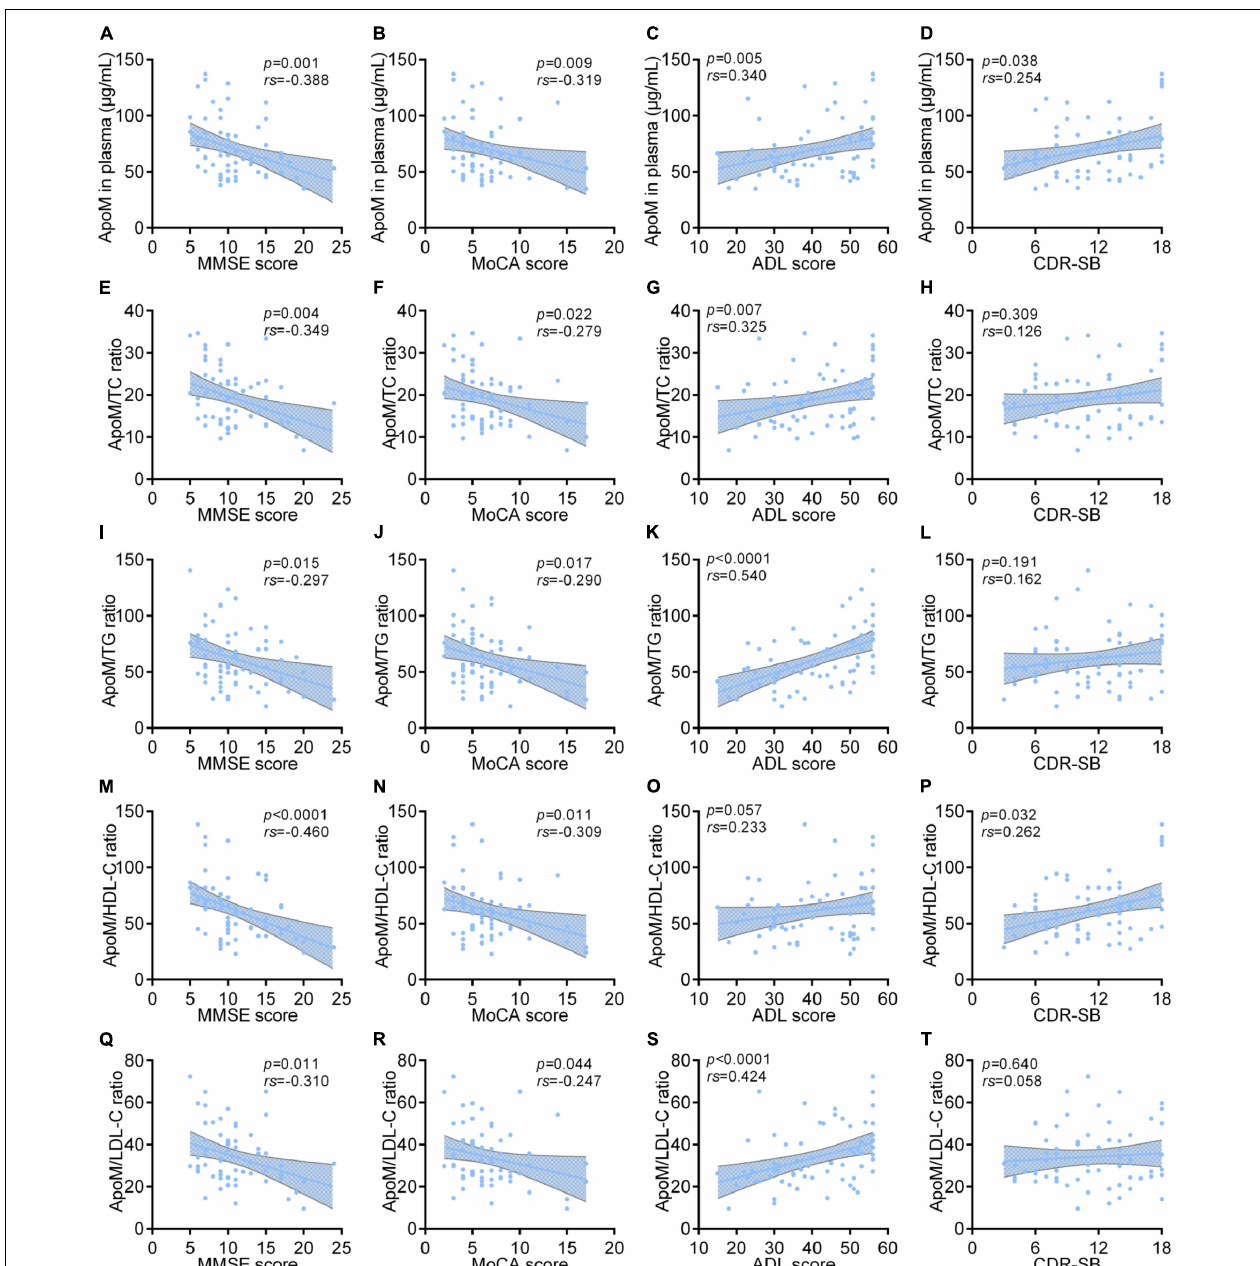
FIGURE 3 | Correlations between plasma ApoM and its derived indicators with clinical characteristics of AD in AD group. The correlations between plasma ApoM with MMSE score (A) , MoCA score (B) , ADL score (C) and CDR-SB (D) . The correlations between ApoM/TC ratio with MMSE score (E) , MoCA score (F) , ADL score (G) and CDR-SB (H) . The correlations between ApoM/TG ratio with MMSE score (I) , MoCA score (J) , ADL score (K) and CDR-SB (L) . The correlations between ApoM/HDL-C ratio with MMSE score (M) , MoCA score (N) , ADL score (O) and CDR-SB (P) . The correlations between ApoM/LDL-C ratio with MMSE score (Q) , MoCA score (R) , ADL score (S) and CDR-SB (T) . ApoM, apolipoprotein M; AD, Alzheimer’s disease; MMSE, Mini–Mental State Examination; MoCA, Montreal Cognitive Assessment; ADL, activities of daily living; CDR-SB, Clinical Dementia Rating Sum of Boxes; TC, total cholesterol; TG, triglyceride; HDL-C, high-density lipoprotein cholesterol; LDL-C, low-density lipoprotein cholesterol. Correlation analyses were performed using Spearman’s rank correlation. p < 0.05 was considered the statistical significance.